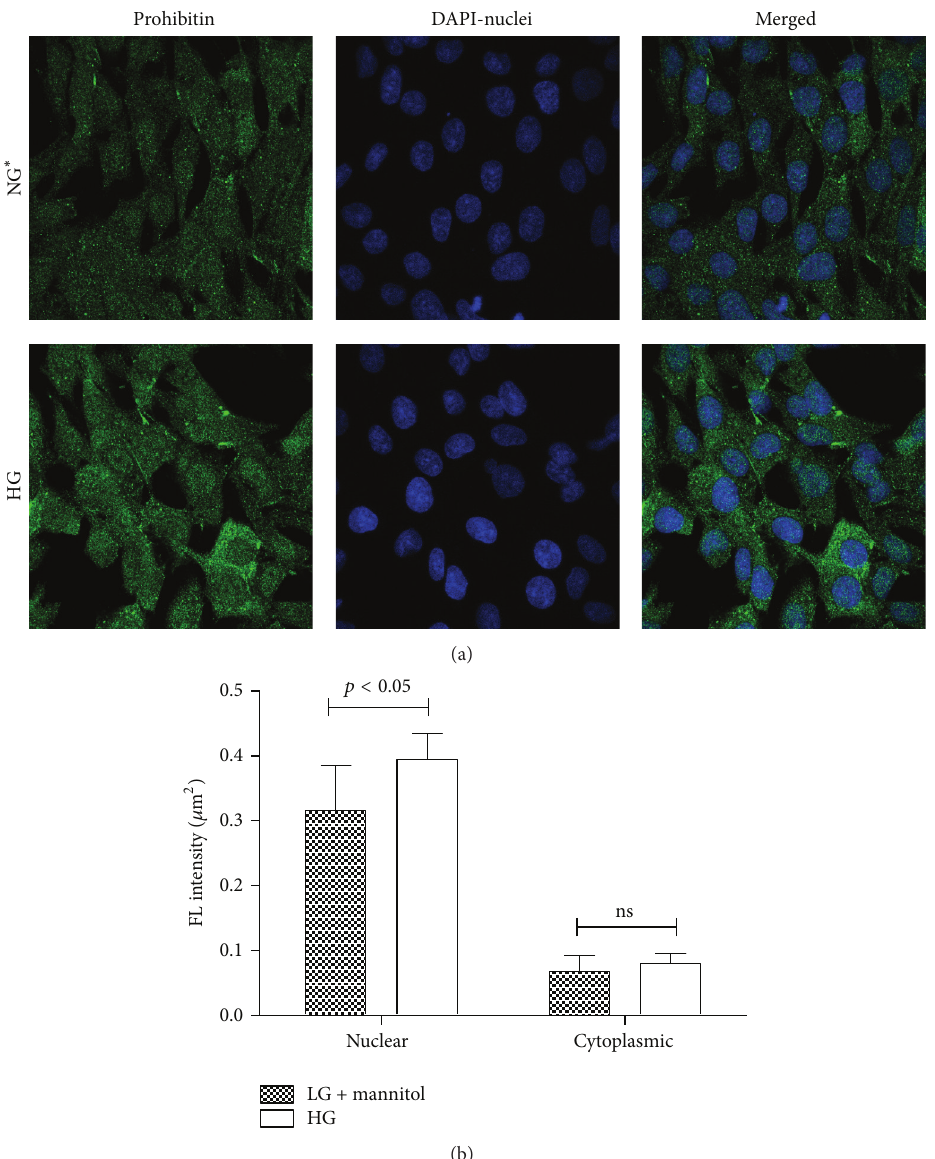
Figure 5: (a) Murine GMCs were seeded into 8-well chambered cover glass, grown, and treated as described in the methods. PHB detection was with the same primary antibody as used for IB. PHB detection with an Alexa Fluor 488 conjugated secondary antibody (green). Nuclei were stained with DAPI (blue). Confocal software was used to estimate pixel density in GMC and in nuclei (as defined by DAPI). Nuclei pixel density was subtracted from total density and plotted (b). Differences were estimated by 𝑡 -test with significance at 𝑝 value < 0.05.